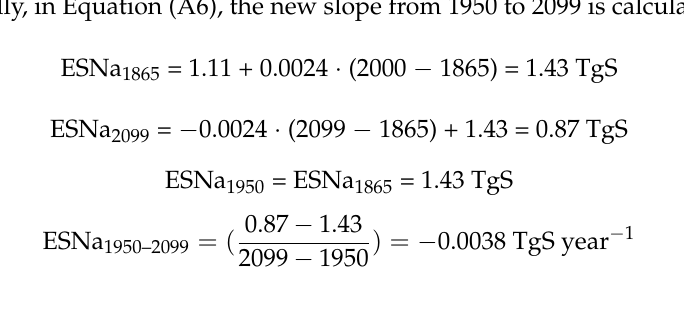
Table A2. Natural sulfur emissions (TgS) and slopes (TgS yr − 1 ) by latitude. Included in order: natural sulfur emissions in the year 2000, slopes used for the entire period, natural sulfur emissions in the year 1865, natural sulfur emissions in the year 2099, and slopes used between 1950 and 2099 [6,13].